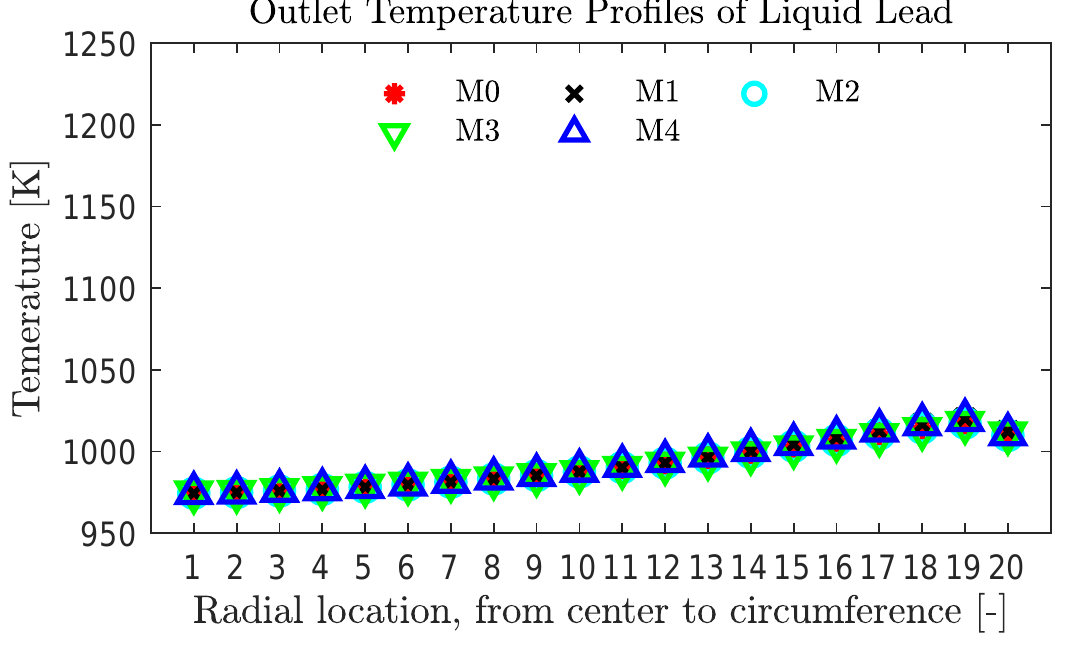
Figure 10. Mesh convergence study of outlet temperature distribution: top, temperature profiles of molten salt; bottom, temperature profiles of liquid